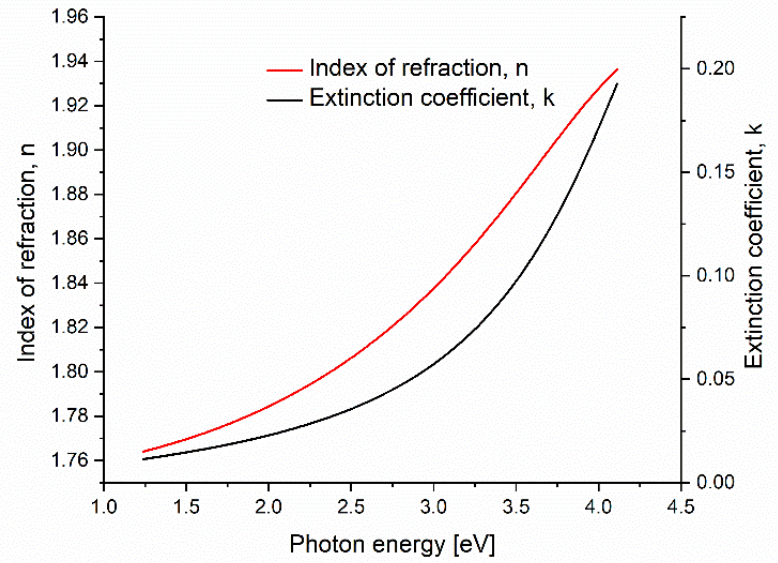
Figure 6. Estimated dispersion laws of GO films on glass substrates by ellipsometry characterization. The curves represent the index of refraction (red curve) and the extinction coefficient (black curve).